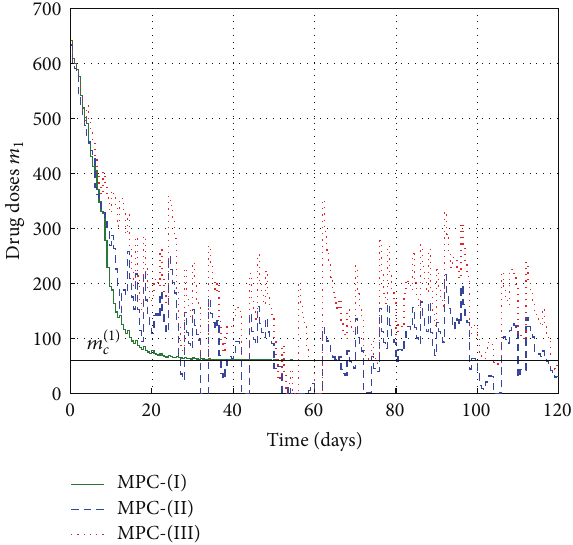
Figure 7: The drug dose of the first type designed by MPC.